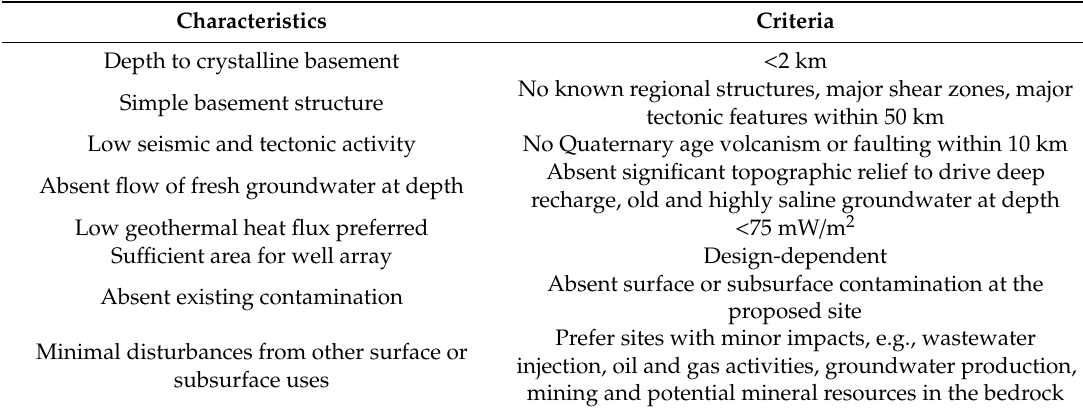
Table 3. Examples of technical criteria for selecting a potential site for consideration, which would contribute to the safety case (taken from Franklin et al. [54]; which modified it from U.S. Nuclear waste technical review board [55] and U.S. Department of Energy (DOE)